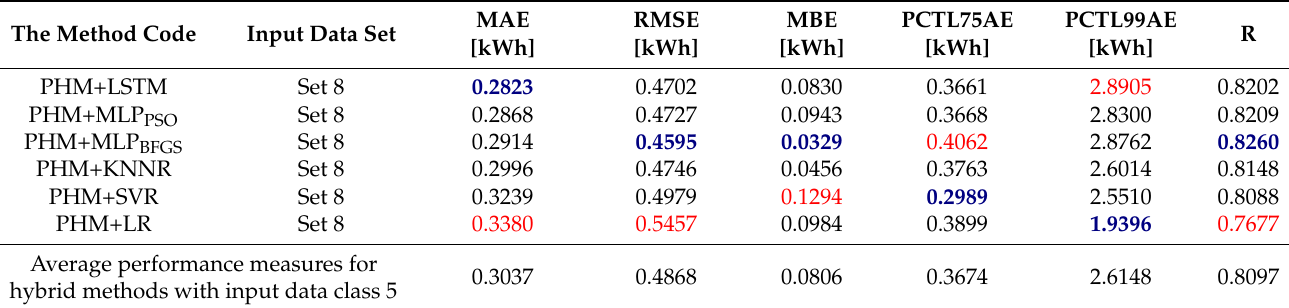
Table 11. Performance measures for hybrid methods with input data class